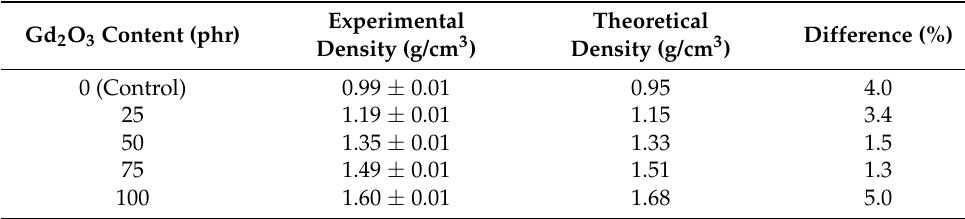
Table 2. Experimental and theoretical densities, as well as the differences between the methods, of Gd 2 O 3 /NR composites with varying Gd 2 O 3 contents of 0, 25, 50, 75, and 100 phr. Experimental densities shown as mean ± standard